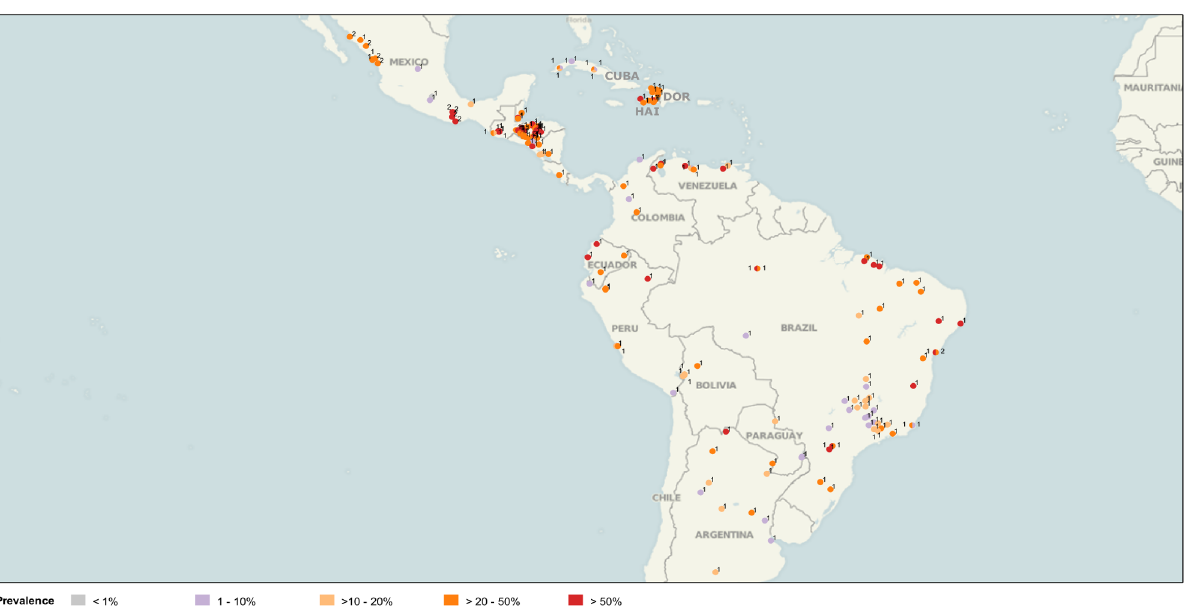
Figure 2. Data published for STH prevalence among SAC in LAC, 2000–2010. Source : PAHO based on literature search for Latin American and the Caribbean. Numbers indicate number of data points found for the same geographical location. (Image created using www.tableausoftware.